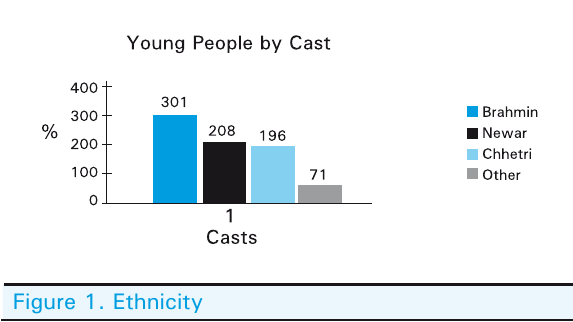
Figure 1. Ethnicity